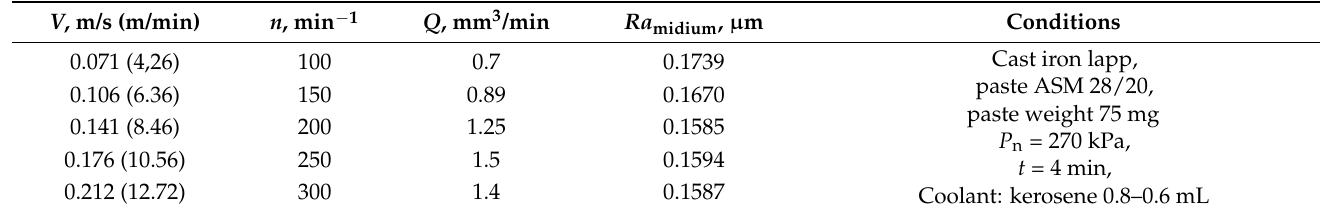
Table 6. The effect of the cutting speed (frequency of lapping vibrations) on the processing perfor- mance and roughness of the lapped surface.